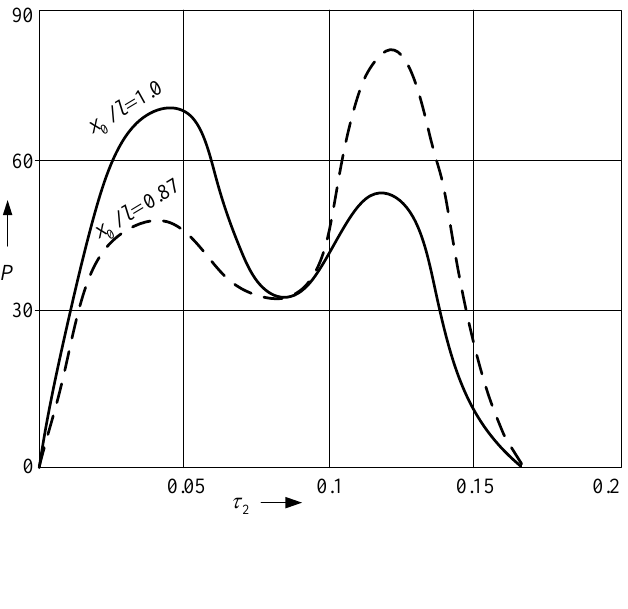
=  T , T —impact duration,  2 1 2 2